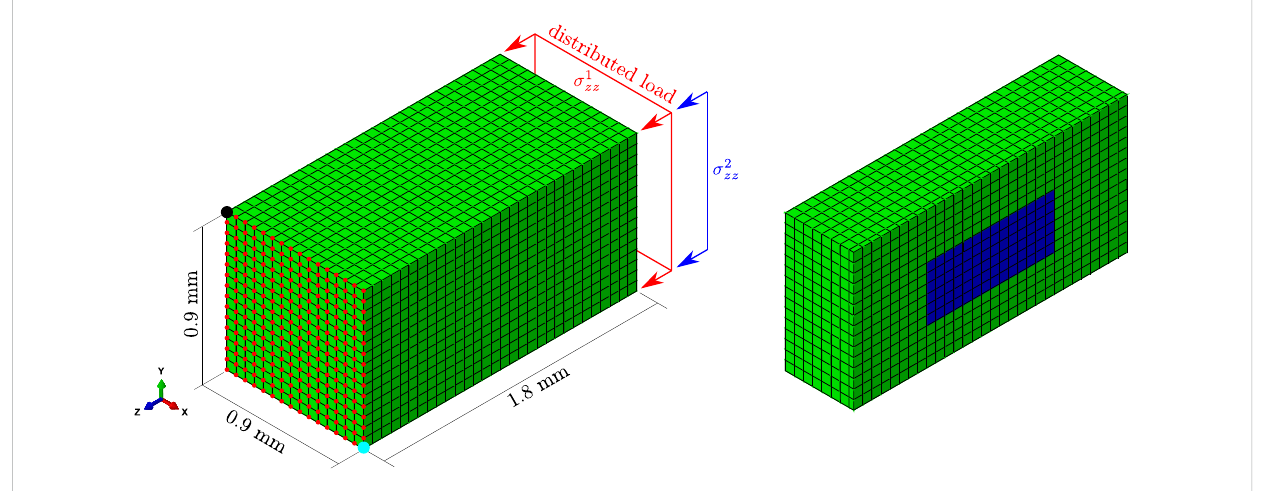
FIGURE 3 FE mesh used in the simulations. Cubic elements of side 60 μ m and type C3D8R from the ABAQUS Element Library (linear 8-noded hexahedrawith reduced integration, 1 integration point) were used. The piece of bone was subjected to uniaxial compression, uniaxial tension or compression plus bending, by applying a distributed load in one face (and also in one edge in the case of compression plus bending) and by preventing certain displacements in the opposite face. On the right-hand side, the model is cut to show in blue a YZ section of the domain under study, which spans a depth of 6 elements in the X direction and is centered along this